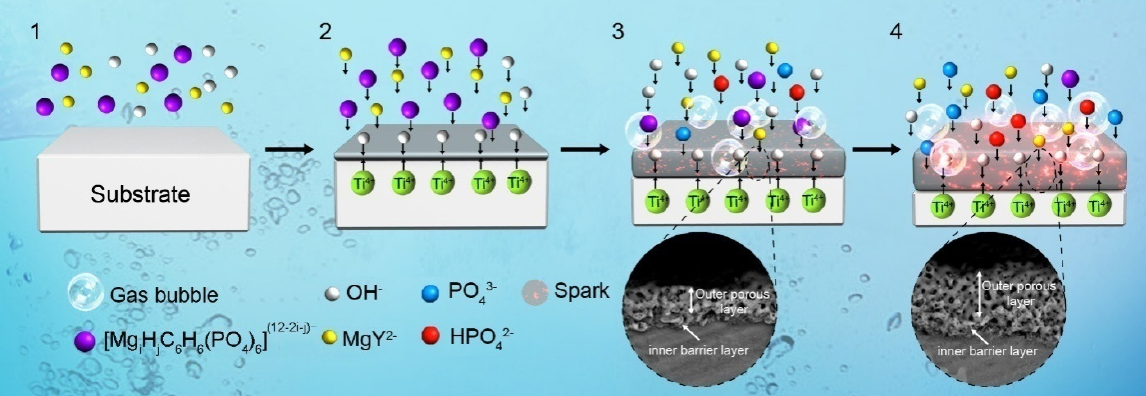
Figure 9. Schematic diagram showing the four stages of anodized coating formation and growth: (1) before anodizing, (2) traditional anodizing, (3) MAO treatment and (4) arc anodizing.